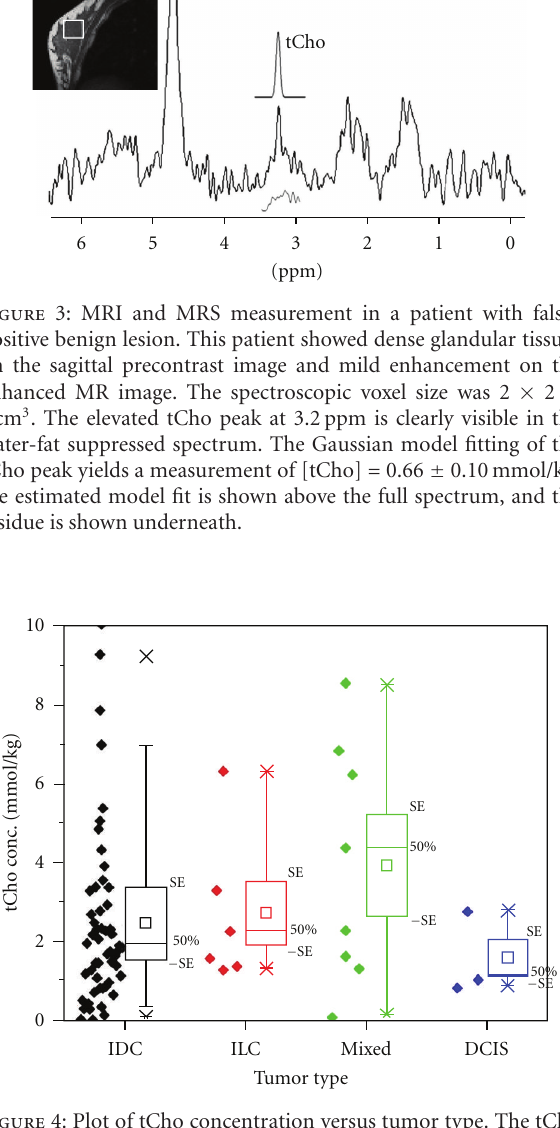
Figure 6: Sensitivity of breast 1 H-MRS in di ff erent histopathologi- cal lesion groups. The sensitivity was significantly higher in invasive cancer than in noninvasive cancer, ductal carcinoma in situ ( P < 0 . 03). The sensitivity was higher in IDC compared to ILC, but not significant ( P > 0 .